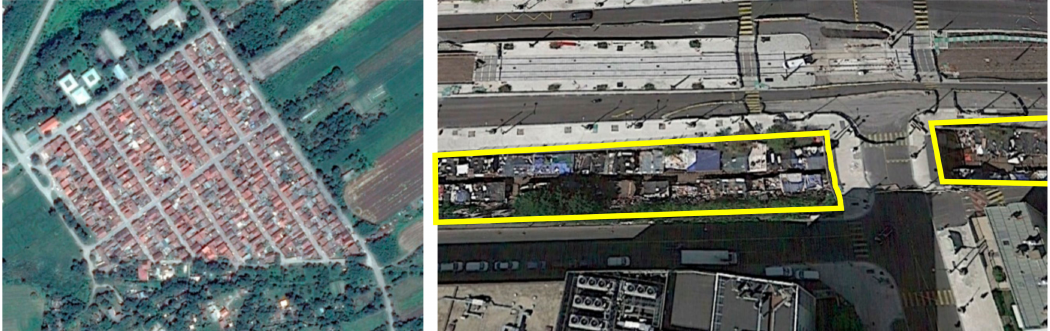
Figure 1. Romani settlements in Europe: Novi Sad, Serbia ( left ) and deprived settlement in Paris (yellow outlines) using the abandoned Petite Ceinture railway ( right ) (Image source: Google Earth).